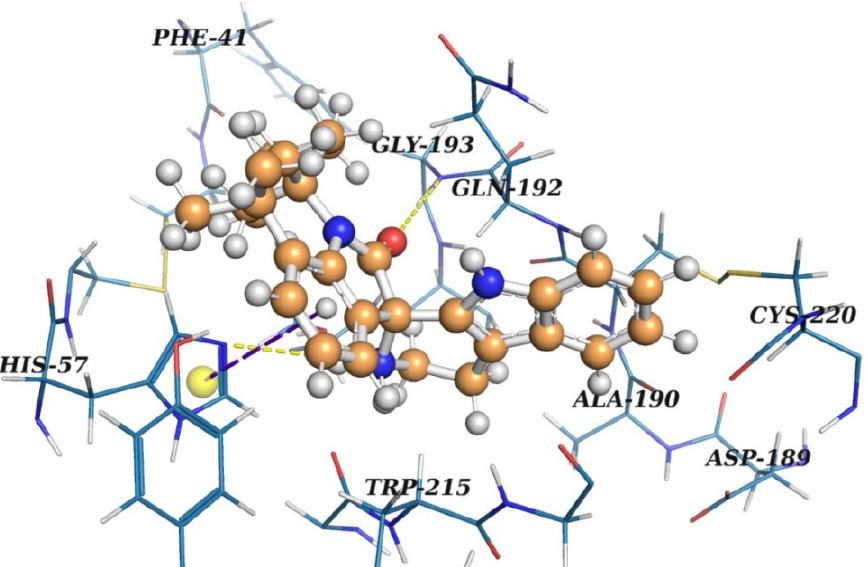
Figure 6. Binding mode of compound 41453 with factor XIIa predicted by docking. A pose after local optimization by PM7 is used. Interactions predicted by PLIP. H-bonds are shown as dashed yellow lines. A dashed violet line indicates pi-stacking. The ligand is presented in a ‘ball-and-stick’ model and colored in orange. Protein residues are shown in a ‘line’ model and colored in marine.